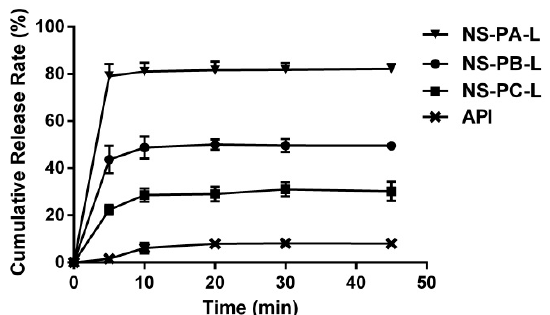
Figure 3. In vitro cumulative release curves of NS-PA-L, NS-PB-L, NS-PC-L, and API (Mean ± SD, n = 3).